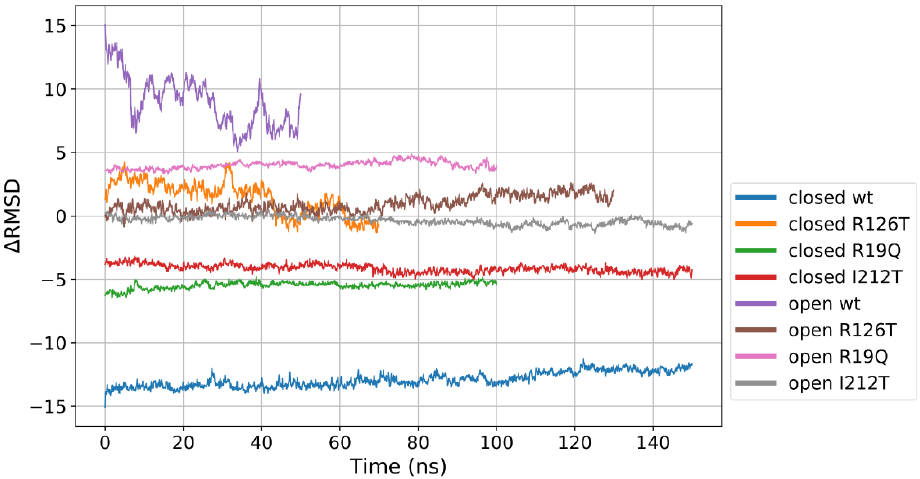
Figure 4. ∆ RMSD calculated for the different investigated systems. The reference closed and open WT structures mark the extremes of the range of values. The different lengths of the data correspond to the different portions of the trajectories that were considered production runs. The values also indicate that neither the closed nor the open WT trajectories could be considered fully equilibrated, since the former displays a slight drift, while the latter is still fluctuating.